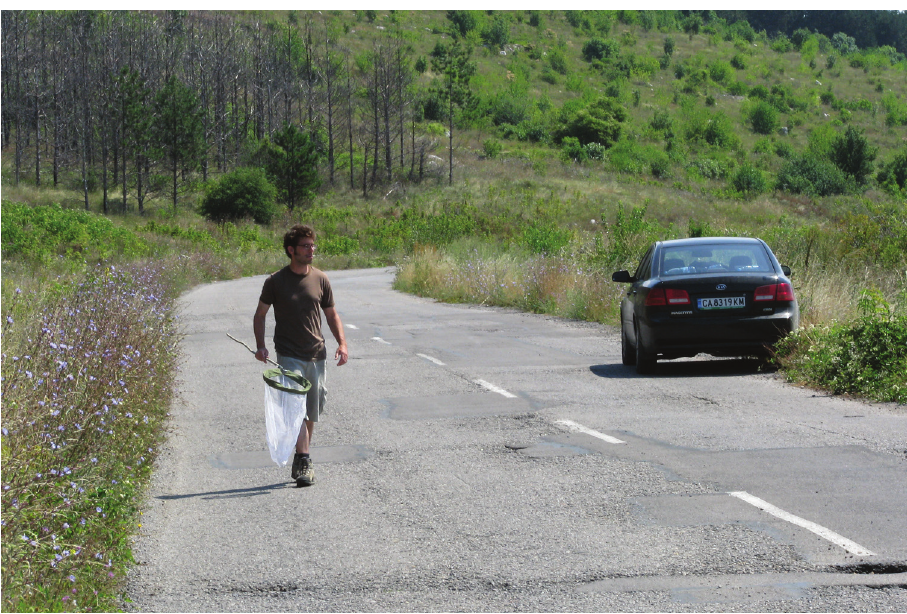
Figure 26. Habitat of P. admetus . W Bulgaria, near Dragoman, 700 m, 29 July 2008. Photo by V.A. Lukhtanov.